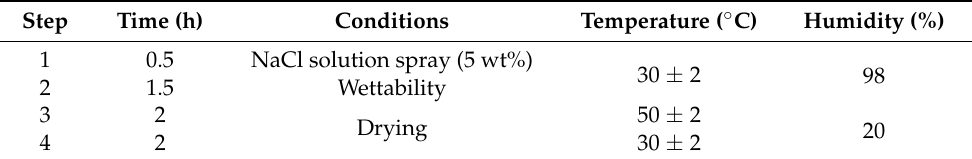
Table 3. Corrosion cycle applied during the accelerated exposure tests (Cycle D of JIS K